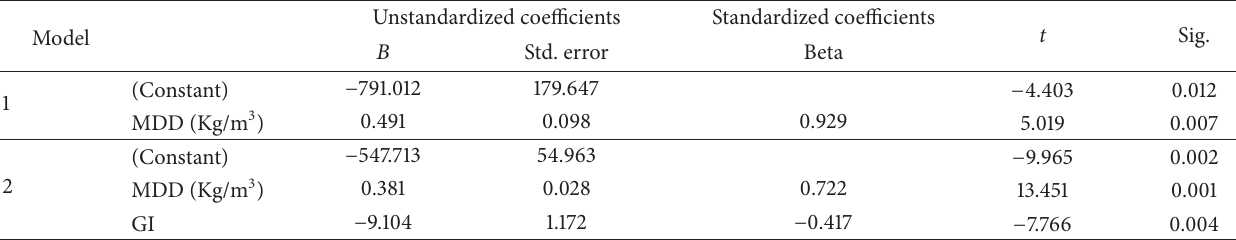
Table 14: Coefficients a